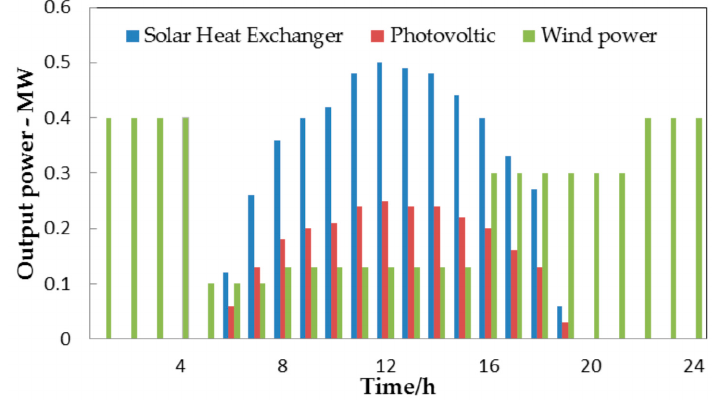
Figure 8. Output power characteristics of PV, PW, and SHE in a sample day.